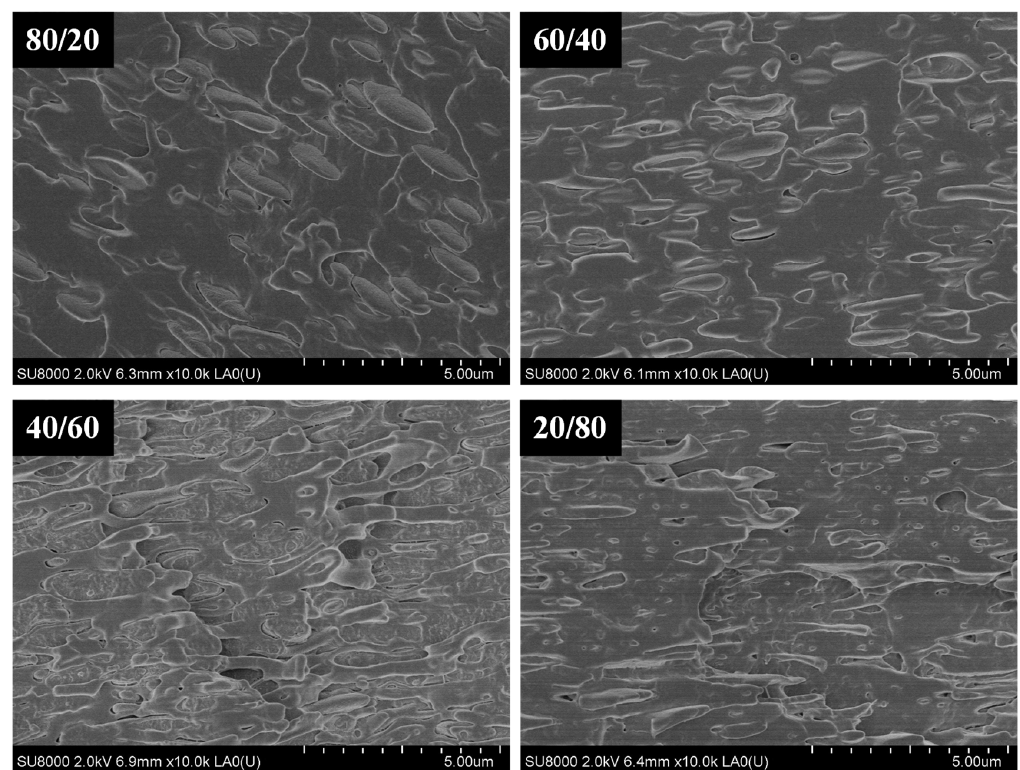
Figure 1. High-resolution SEM image for PLLA/INT-WS 2 , PVDF/INT-WS 2 , binary PLLA/PVDF, and ternary PLLA/PVDF/INT-WS 2 hybrid nanocomposites.